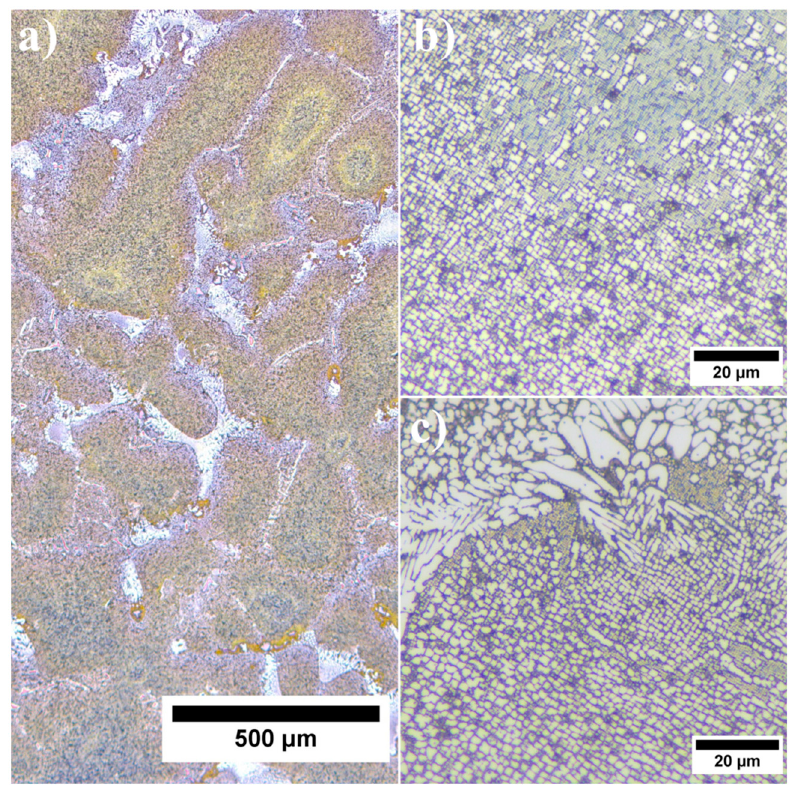
Figure 1. Inhomogeneous microstructure of René 108 superalloy: ( a ) dendritic structure; ( b ) precipitates in dendritic regions; ( c ) precipitates in interdendritic spaces.